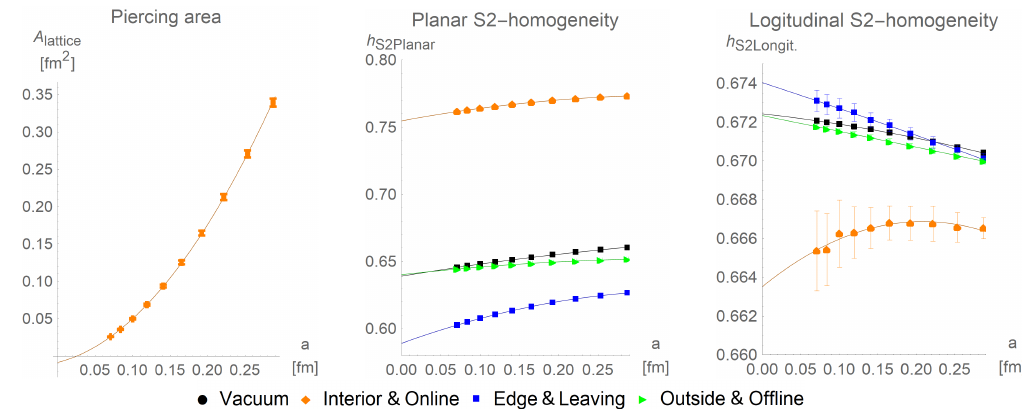
Figure 10. The data of vortex thickness ( left ), planar S2-homogeneity ( middle ) and longitudinal S2-homogeneity ( right ) are shown in dependence of the lattice spacing a . The homogeneities are distinguished for vortex interior, vortex edge, vortex outside and the average over the whole volume of the lattice (vacuum). All three diagrams indicate a vanishing vortex thickness. From the data in the middle and the right diagram we conclude that the vortex is inhomogeneous in longitudinal direction, but homogeneous in planar directions.